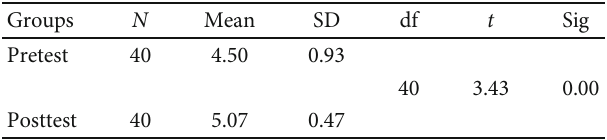
Table 5: Control group pretest-posttest result comparison.